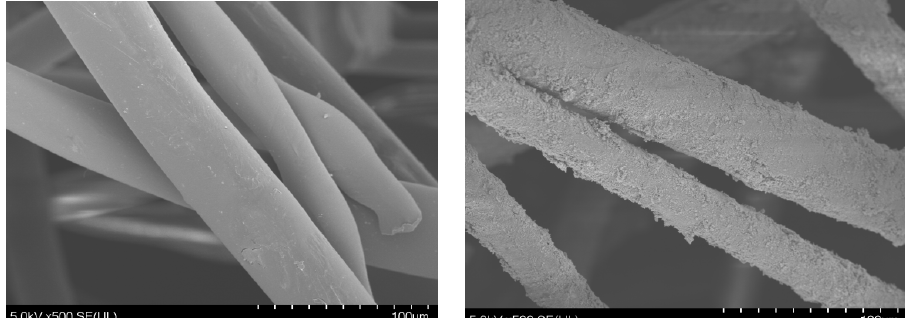
Figure 12. SEM of the PET scan before and after catalyst